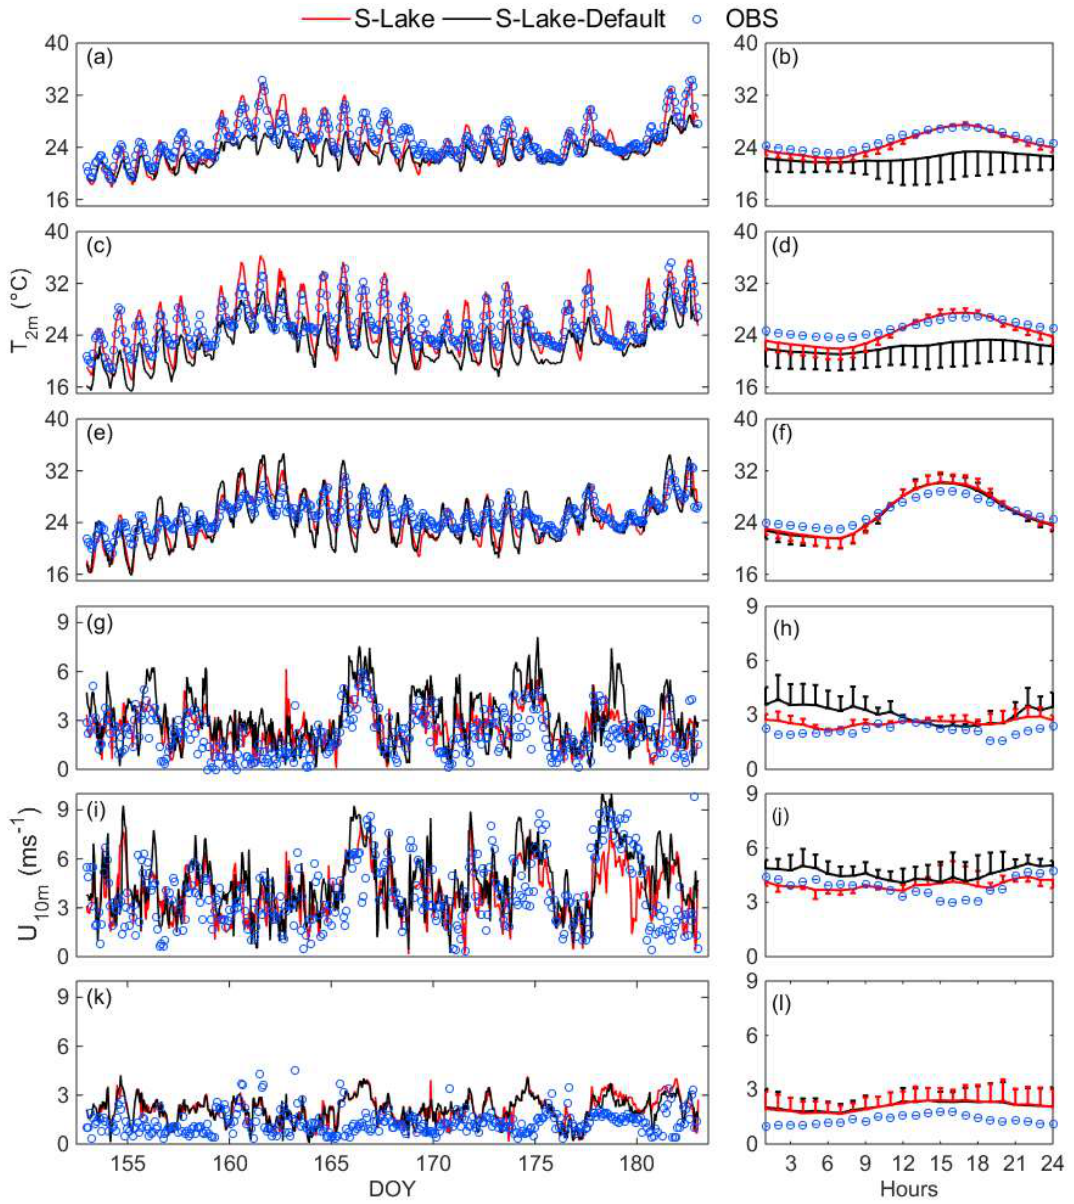
Figure 3. Modeled and observed temporal evolution of ( a ) air temperature at 2 m for K5002 station (°C); ( b ) daily average value and error bar (°C); ( c ) air temperature at 2 m for K5060 station (°C); ( d ) daily average value and error bar (°C); ( e ) air temperature at 2 m for 58443 station (°C); ( f ) daily average value and error bar (°C); ( g ) wind speed at 10 m for K5002 station (m·s −1 ); ( h ) daily average value and error bar (m·s −1 ); ( i ) wind speed at 10 m for K5060 station (m·s −1 ); ( j ) daily average value and error bar (m·s −1 ); ( k ) wind speed at 10 m for 58443 station (m·s −1 ); ( l ) daily average value and error bar (m·s −1 ); from 1 June to 30 June 2012.